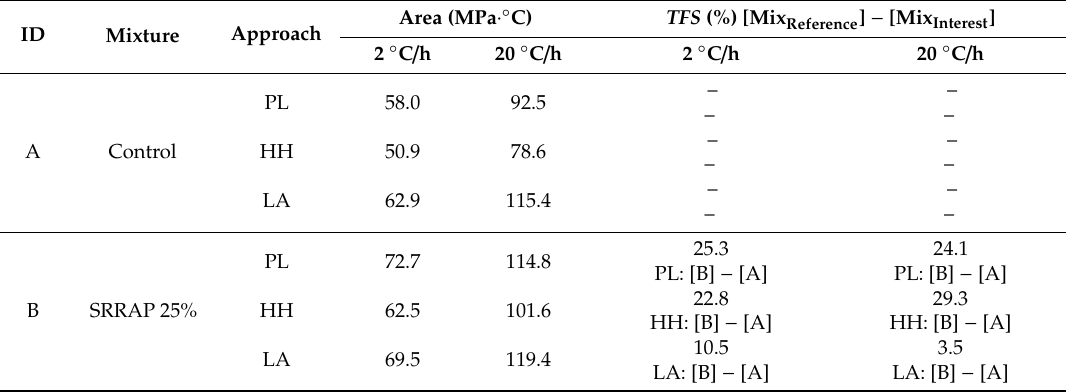
Table 5. Thermal stress factor (TSF) computation results.